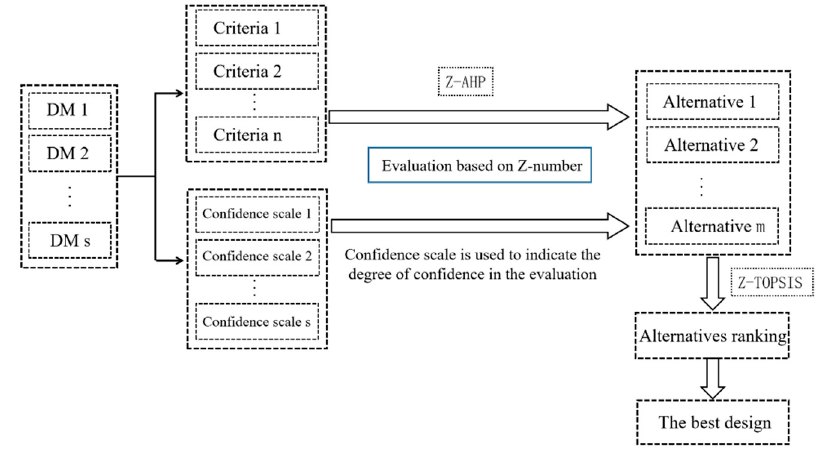
Figure 5. The proposed conceptual design evaluation framework.